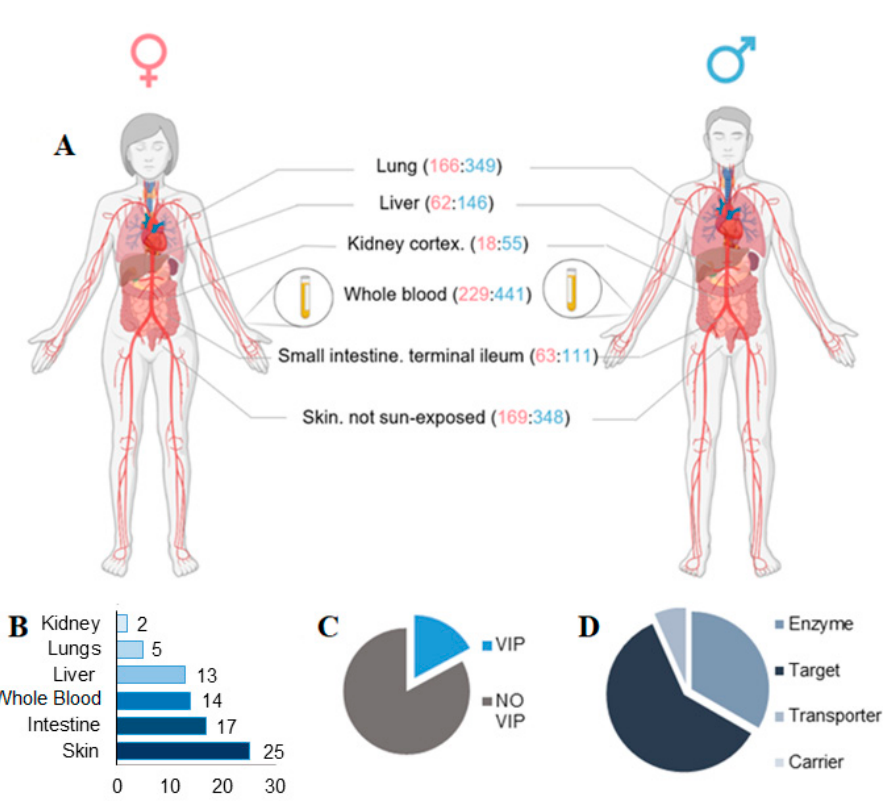
Figure 2. Sex-biases pharmacogenes identified in key tissue implicate in drug metabolism. ( A ) Tissue types relevant for drug metabolism are indicated, with sample numbers from GTEx v8 genotyped donors (females:males, in parentheses). ( B ) The number of SBDR identified in each tissue relevant for drug metabolism is indicated (FDR < 0.05). ( C ) Proportions of VIP genes and ( D ) drug target, transporter, carrier, and enzymes identified according to PharmGKB and DrugBank classification are indicate respectively. Panel A is created with BioRender.com.